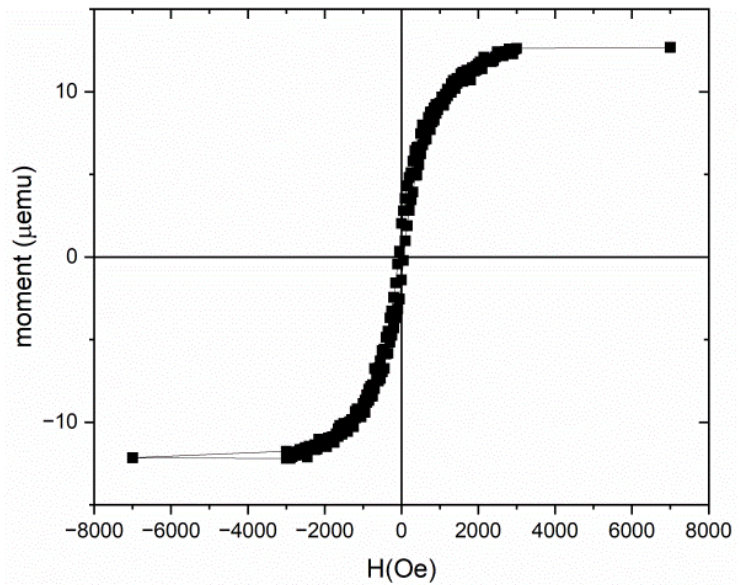
Figure 4. Hysteresis loop along the α -FeSi 2 NRs on the Si(111)-4 ◦ surface with the linear diamagnetic slope subtracted from the silicon substrate.